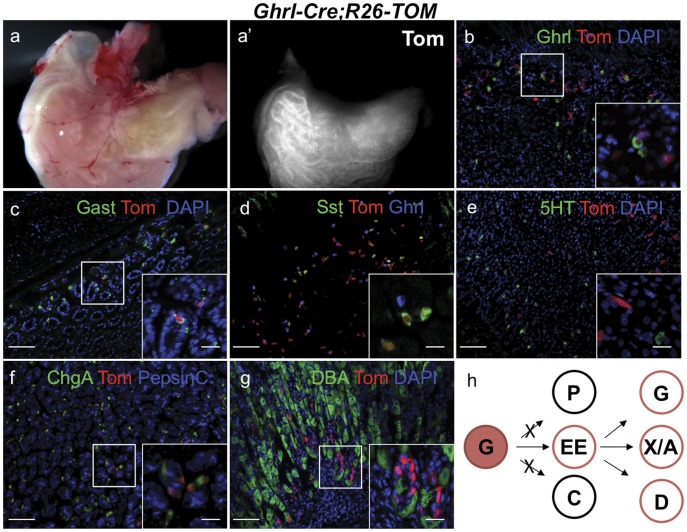
Ghrelin lineage-labeled cells are committed to the endocrine lineage and do not differentiate into chief nor parietal cells in the stomach.Representative images showing immunofluorescence for gastric cell markers and direct reporter fluorescence on cryosections and whole mounts of stomach from 6w Ghrl-Cre;R26-TOM mice. Whole mount stomach shows reporter fluorescence in the corpus and in the pyloric antrum but not in the fundus (a–a’). Although, almost all ghrelin-expressing cells were labeled with TOM, not all TOM+ cells co-localize with ghrelin, indicating ghrelin-expressing cells differentiate into other cell types (b). The tomato reporter is expressed in gastrin-expressing G cells (c), as well as a large number of somatostatin-expressing D cells in the corpus of the stomach (d), but not serotonin-expressing cells (e). All TOM+ cells were also Chromogranin A+, indicative of an endocrine commitment of the ghrelin-expressing cells in the stomach (f). Ghrelin-labeled cells did not colocalize with pepsin C, a marker for chief cells (f), or with DBA, a marker of parietal cell (g). (h) Schematic representation of the lineage tracing experiments defining the fate of ghrelin-labeled cells in the stomach. G, gastrin producing cells; P, parietal cells; EE, enteroendocrine cells; C, chief cells; X/A, ghrelin-producing X/A-like cells; D, somatostatin producing cells. Scale bar, low magnification panels = 50 µm, insets = 20 µm.